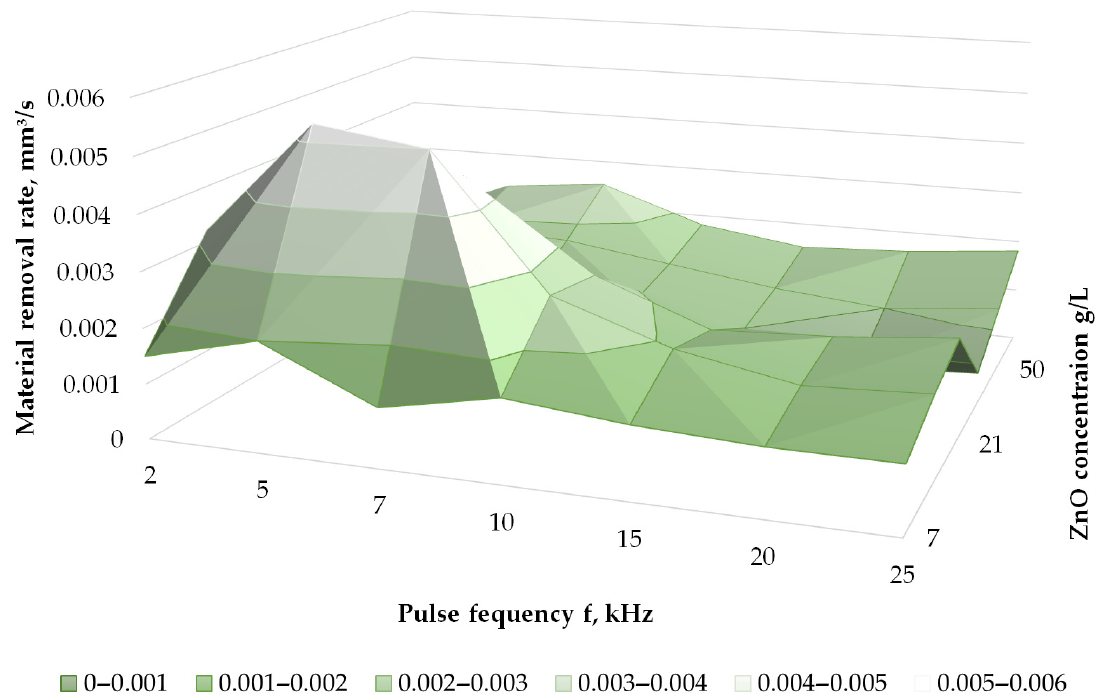
Figure 9. The electrical discharge machining alumina performance using a double-layer copper tape assisting coating of 80 µm in thickness with ZnO powder-mixed deionized water-based dielectric medium for a pulse duration of 1 µs.